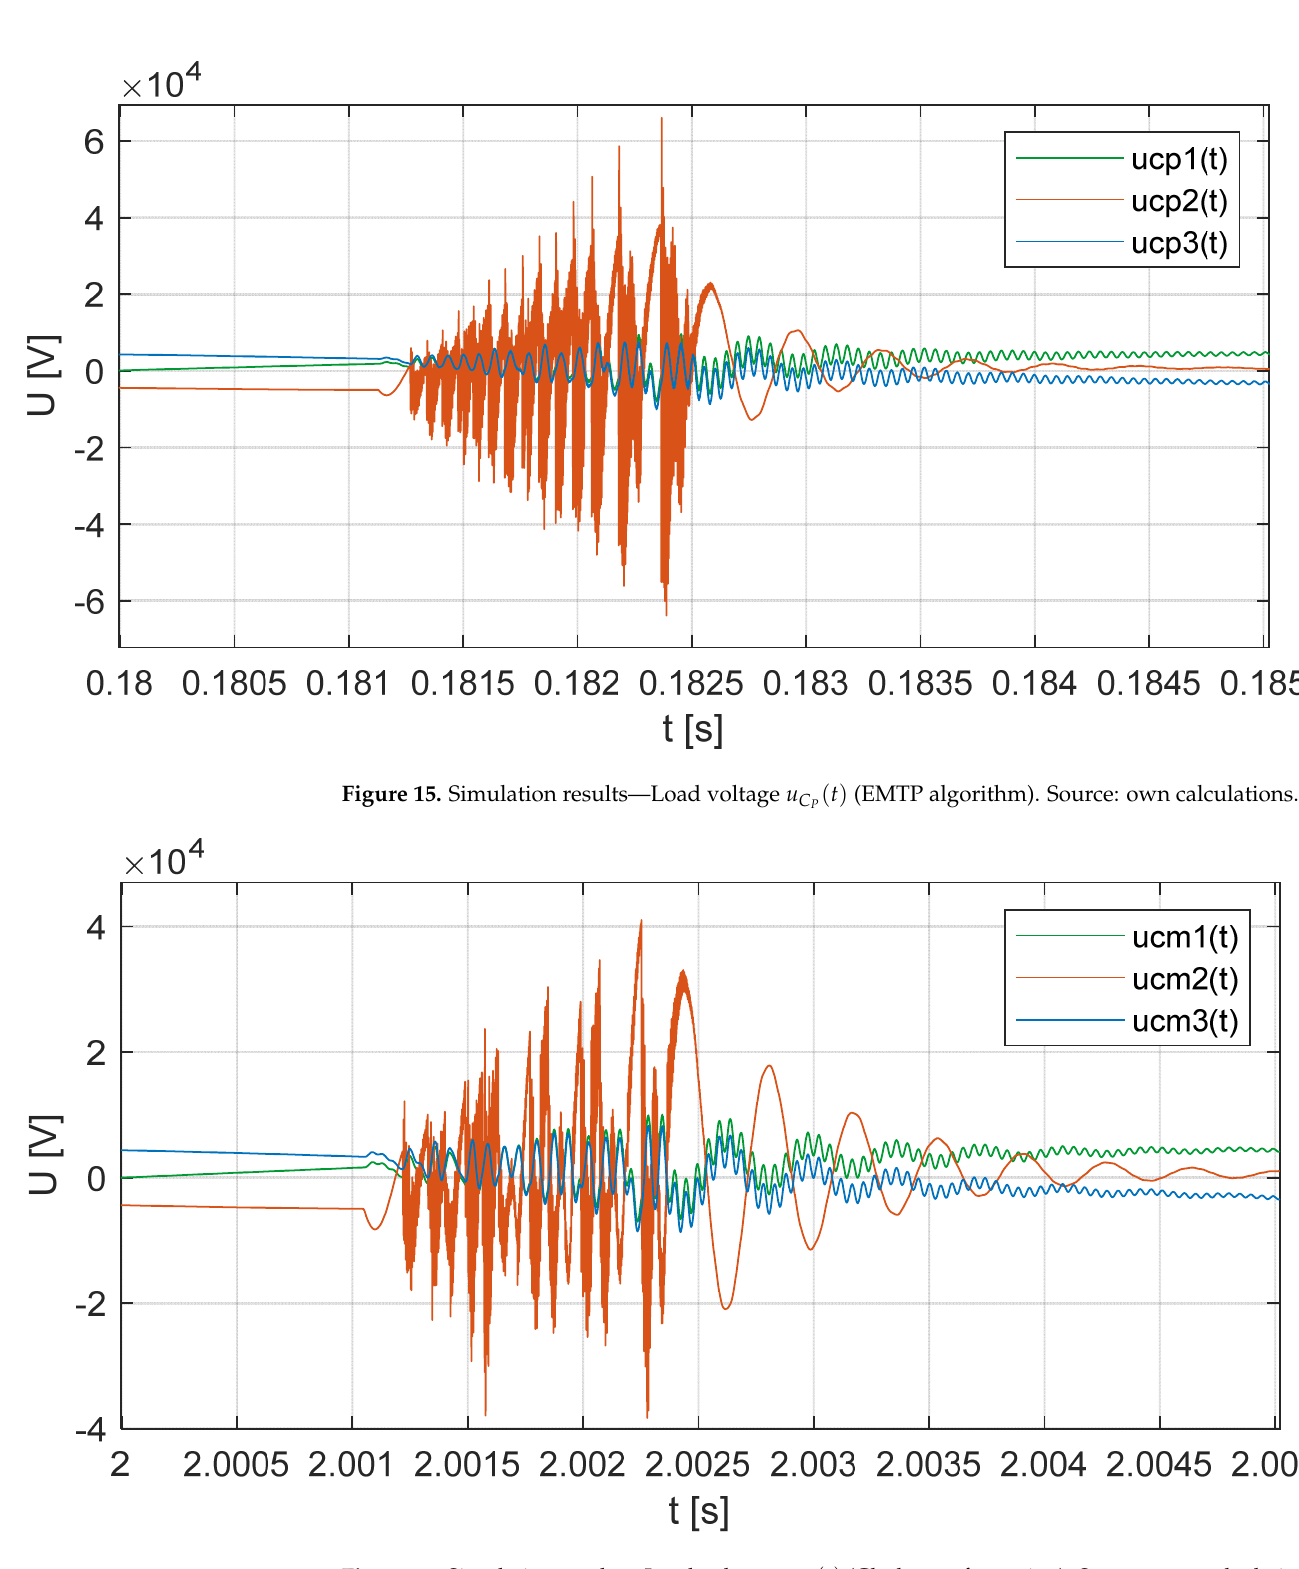
Figure 16. Simulation results—Load voltage 𝑢 tions.